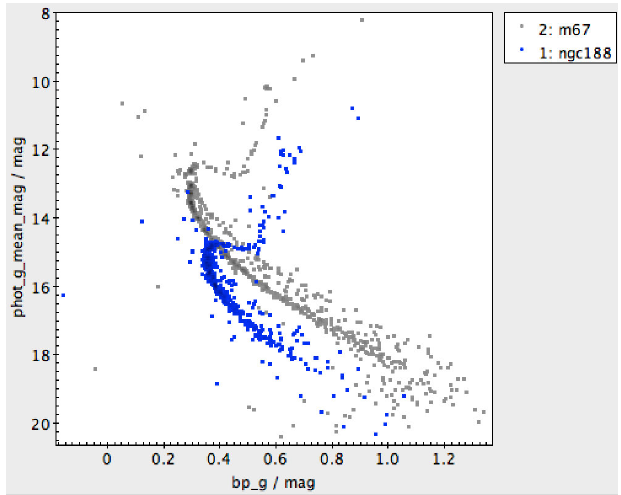
Fig. 73.— Colour-magnitude plots for the open star clusters NGC 188 and M 67